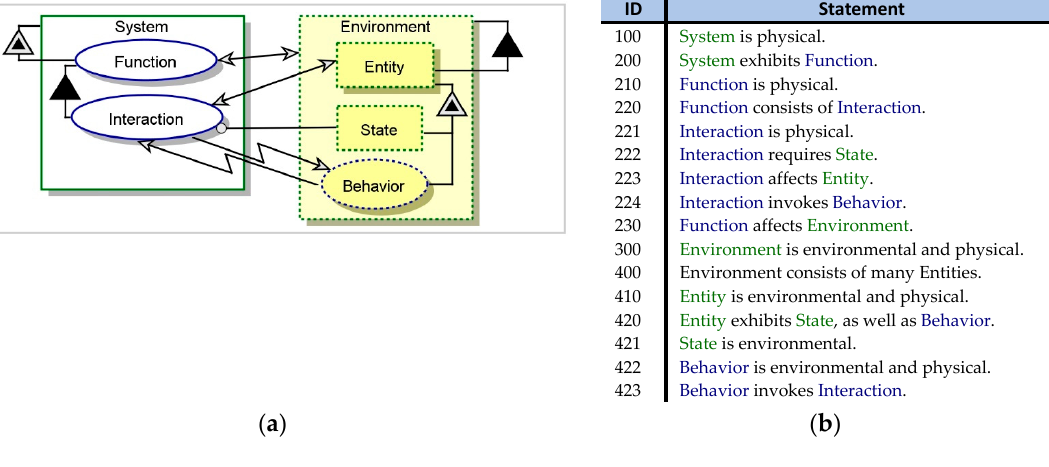
Figure 1. System diagram of a generic naïve system-environment interaction: OPD ( a ) and its equivalent OPL text ( b ).